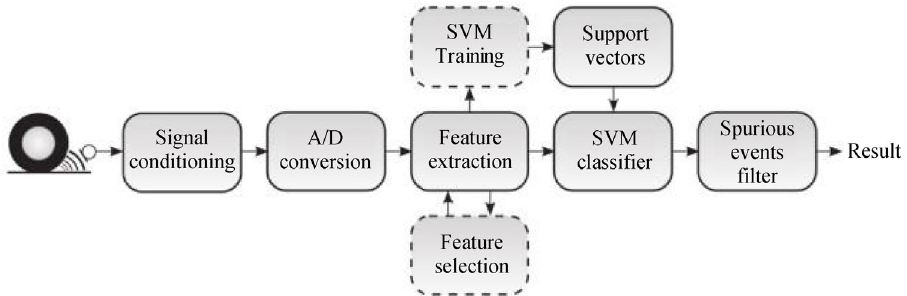
Fig. 4 Friction estimation algorithm using acoustic sensors. Reproduce with permission from Ref. [31]. Copyright Elsevier,